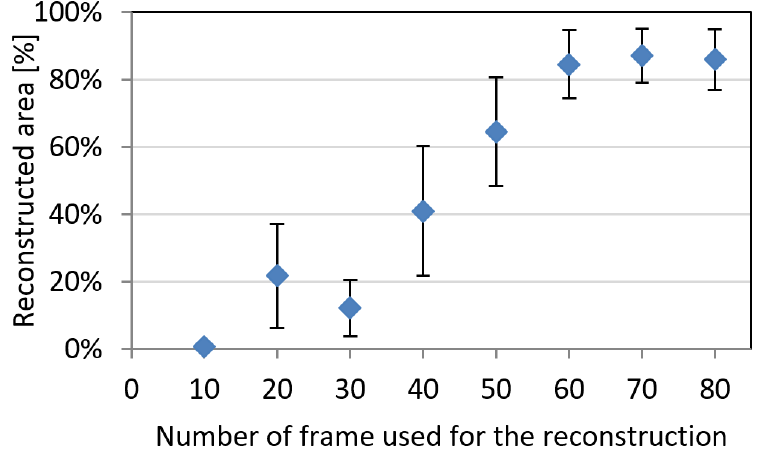
Figure 3. Reconstruction area with a number of frames ranging between 10 and 80. Error bars indicate standard deviation on three repeated reconstructed processes.